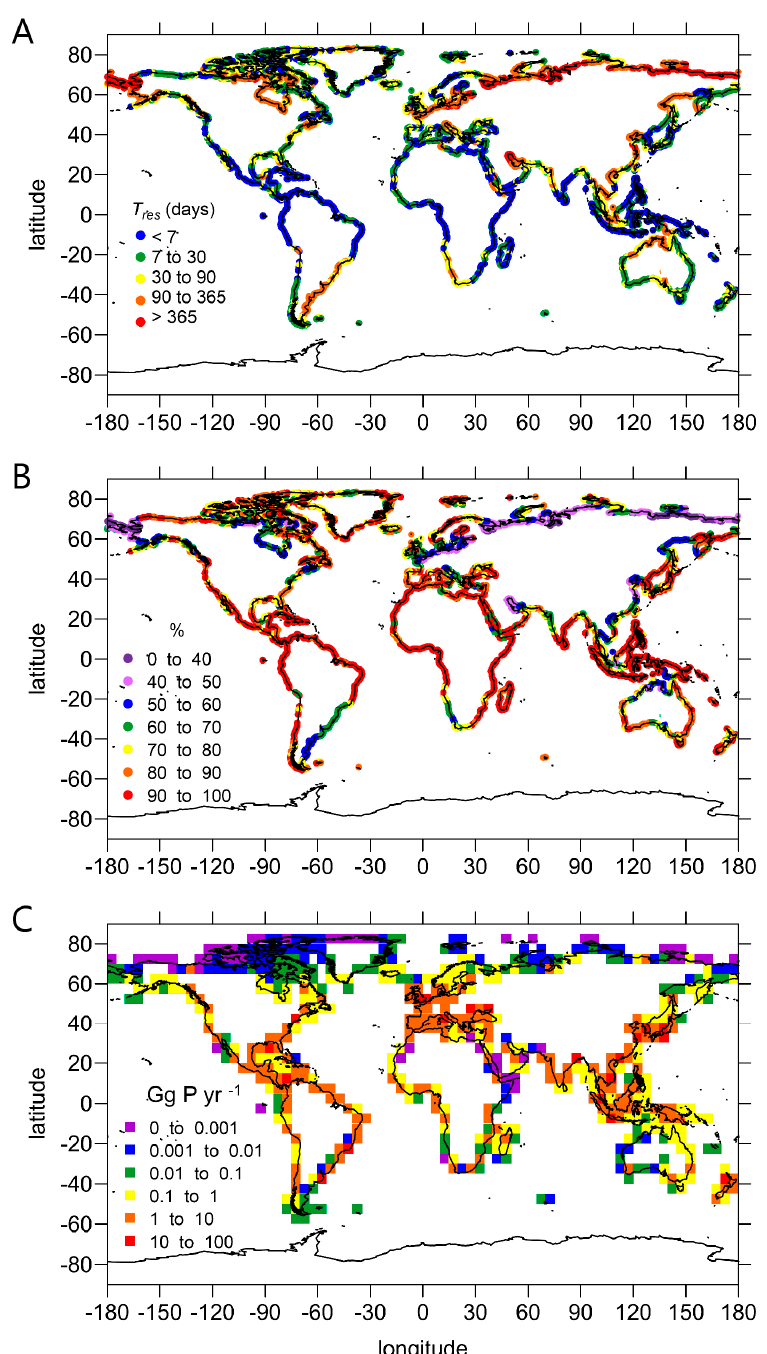
Figure 14. Based on the global scale, simple mathematical modeling of Sharples et al. [210]: ( A ) average residence time “ T res ” on the continental shelf; ( B ) estimated proportion of riverine DIP (dissolved inorganic phosphorus) exported to the open ocean; ( C ) estimated annual DIP mass export to the open ocean. The authors performed the same calculations for dissolved inorganic nitrogen and provided uncertainty estimates (not shown here). (Modified with permission from J. Sharples, Global Biogeochemical Cycles; published by Wiley, 2017).